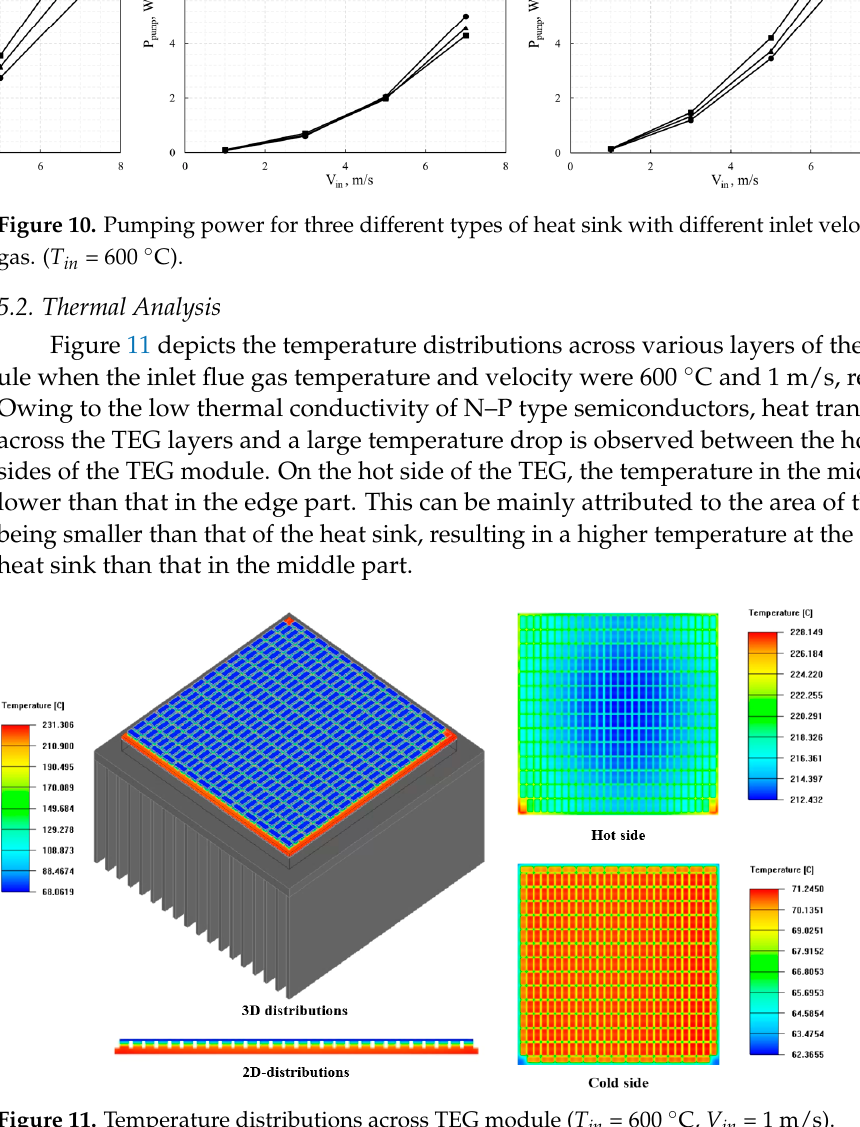
Figure 11. Temperature distributions across TEG module ( T in = 600 °C, V in = 1 m/s).